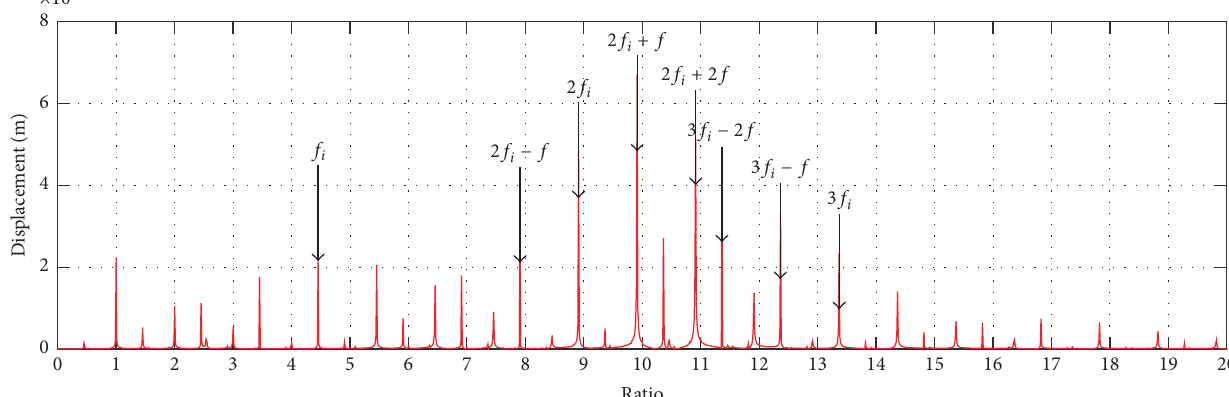
Figure 12: The spectral diagrams of the faulted system with SFD mounted on the normal bearing at 𝜔 = 100 rad/s and width = 1𝑒 − 3 m.